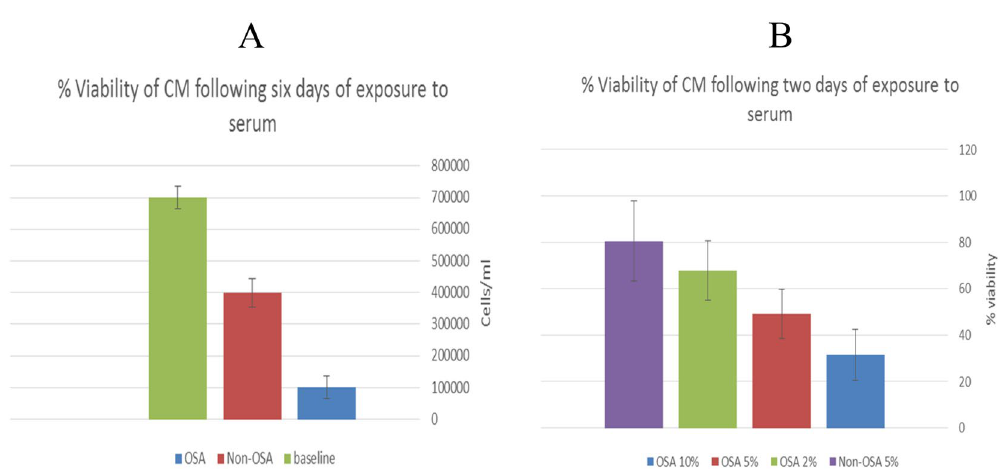
Figure 7. Rat neonatal CM were exposed to FCS (baseline), Non-OSA serum and OSA sera for 6 days, in three consecutive experiments. After 6 days of exposure, dead cells were differentiated with trypan blue, while live cells were counted manually under the microscope using hematocytometer chambers. ( A ) Average live cell count on day 6 of all 3 experiments. ( B ) XTT viability assay following 2 days of exposure to 5% FCS, 5% non- OSA sera, 2%, 5% and 10% OSA